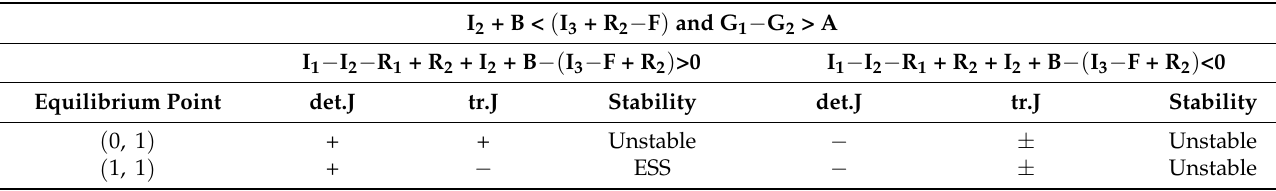
Table 8. Stability results of the local equilibrium point in Scenario 3.